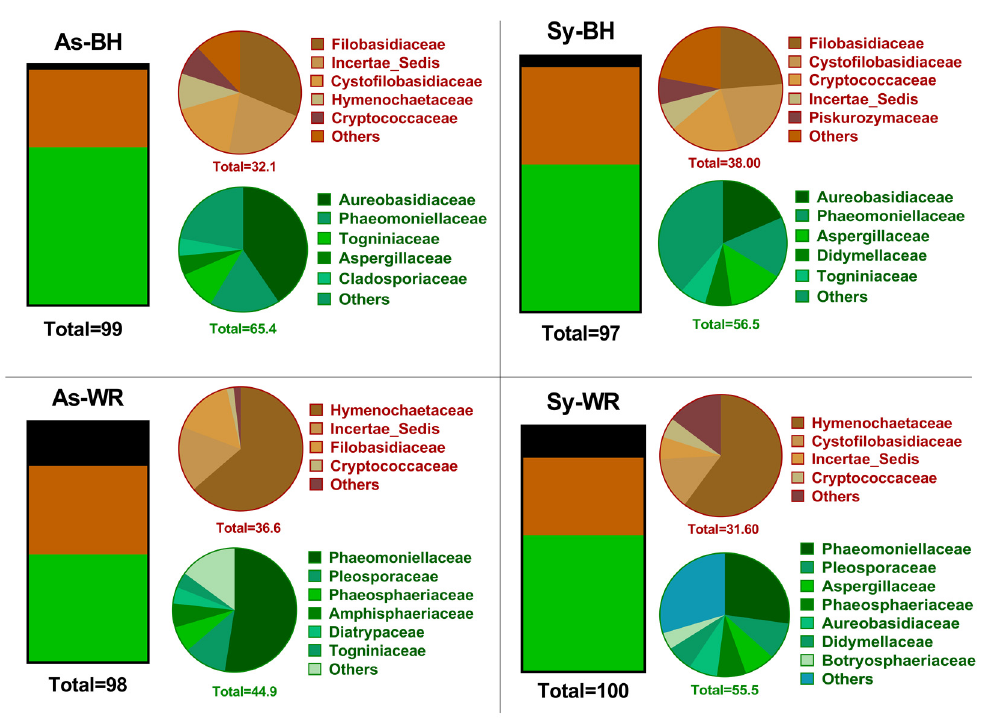
Figure 3. Relative abundance of fungal phyla and families resulting from culture-independent fungal community analysis. Green color represents phylum Ascomycota, orange color represents phylum Basidiomycota, and black color represents phylum Mortierellomycota. Table 1. Alpha-diversity estimation of the fungal community resulting from the culture-independent analysis of 48 wood